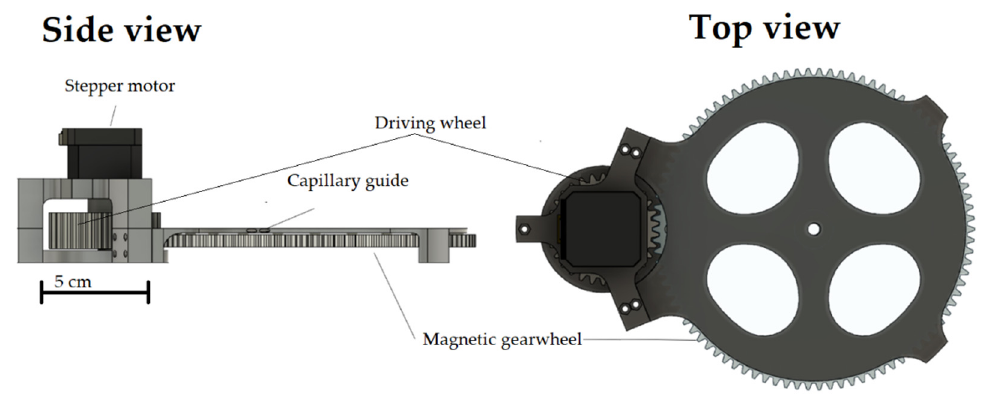
Figure 2. CAD drawing of the pump structure in side view ( left ) and top view ( right ) .